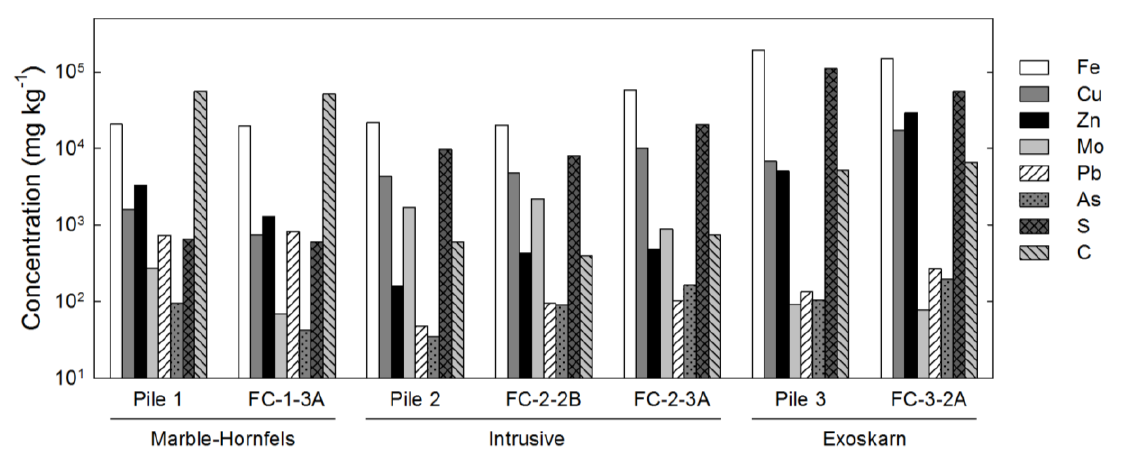
Figure 1. Whole-rock analyses by X-ray fluorescence (XRF) (Fe, Cu, Zn, Mo, Pb and As) or combustion-infrared detection (S and C) for waste rock samples collected in February